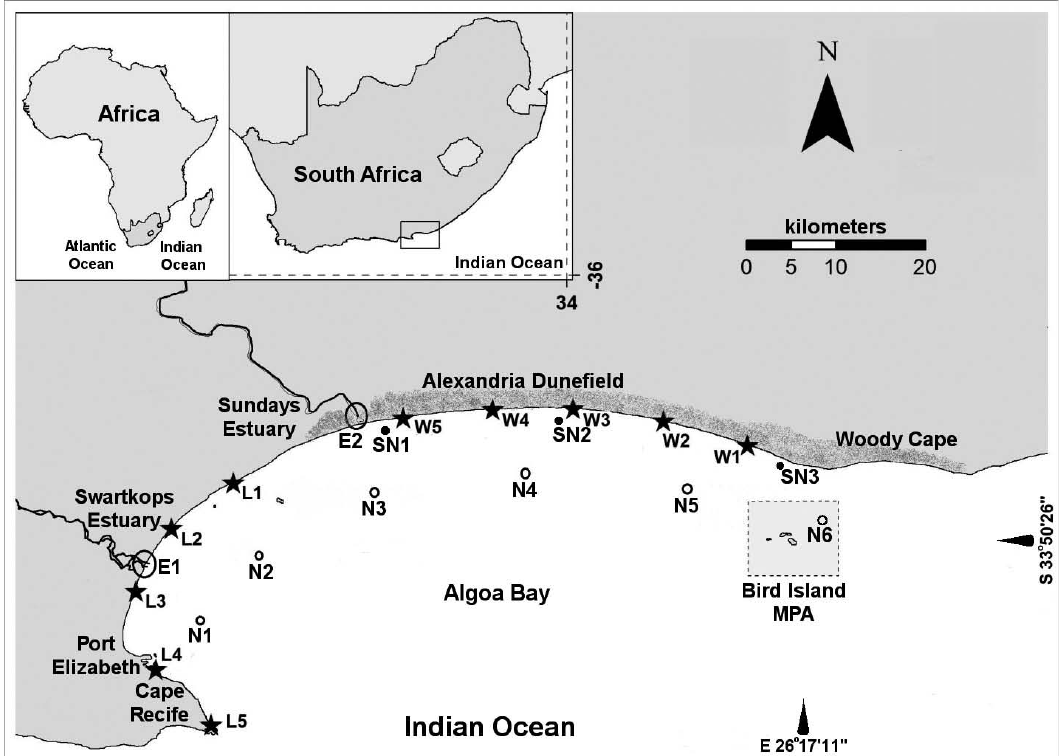
Fig. 1. – The geographic position of Algoa Bay, South Africa, showing location of sampling stations between Cape Recife and Woody Cape used to assess nursery area use by early developmental stages of Solea turbynei . Nearshore: N1 - 6 (30 m depth contour), SN 1-3 (~5 m and ~15 m depth contours); Surf zone: L1 - 5 (leeward side) and W1 - 5 (windward side); estuaries: Swartkops (E1) and Sundays